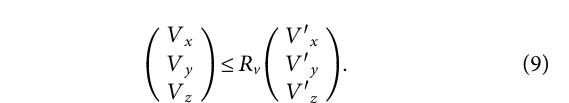
FIGURE 10 | Rockfall trajectories under seismic load, sine wave, 0.5 g, 5 Hz, 25 s (C2).